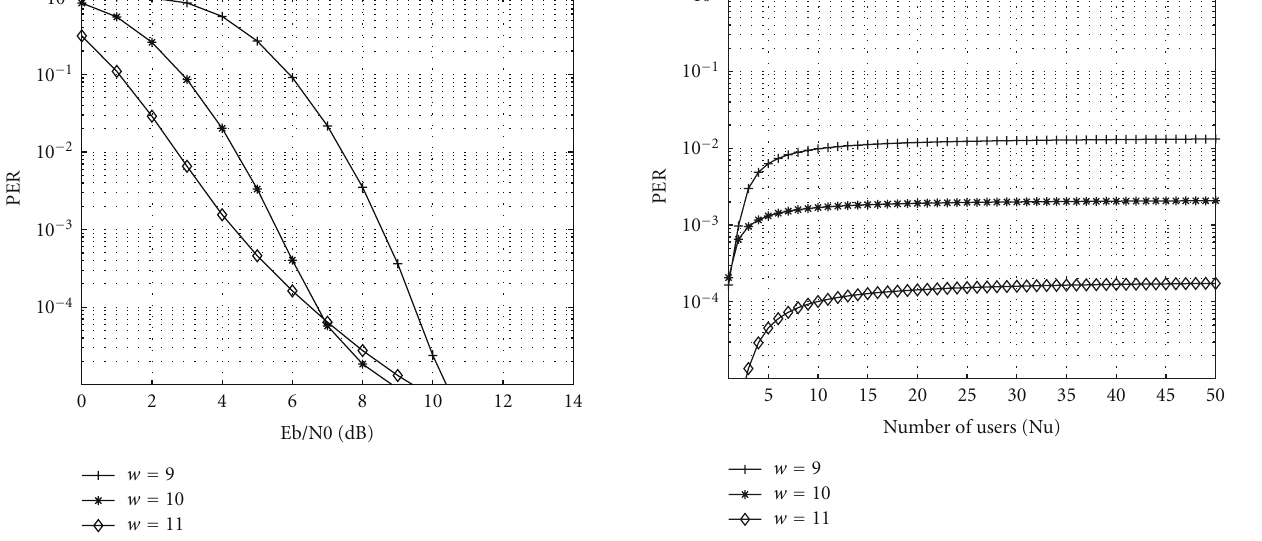
Figure 9: Influence of code weight w on 8-PIM performance for the optimal v th = 7 .